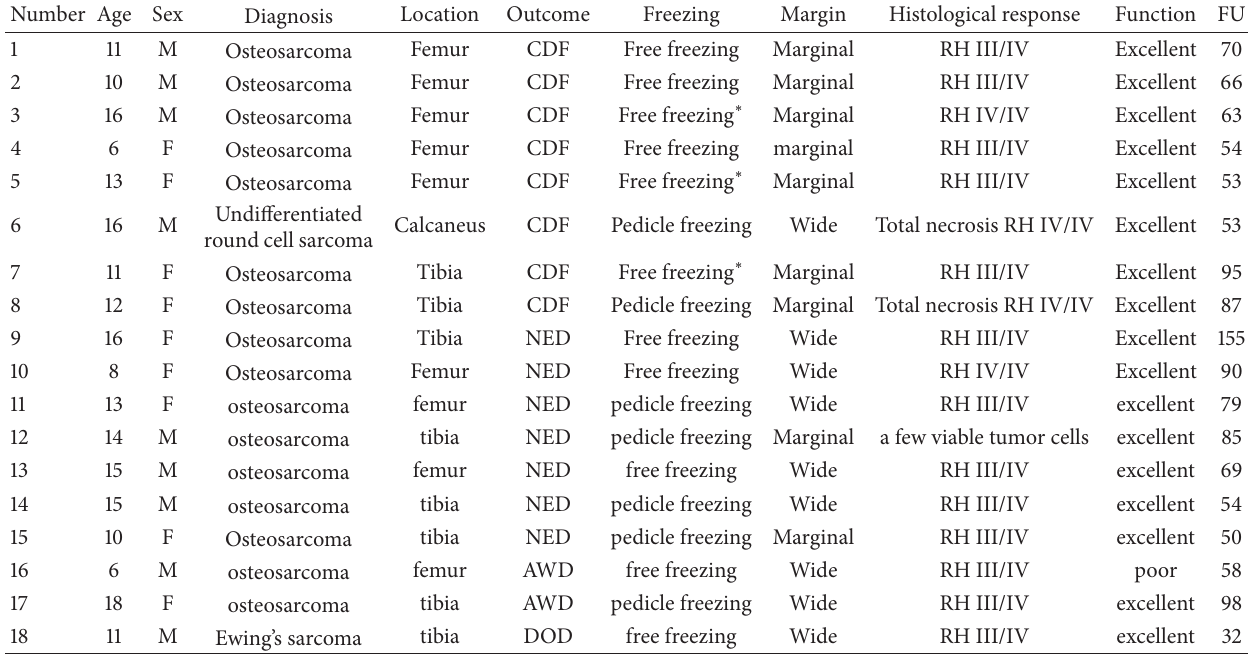
Table 1: Descriptive criteria of all